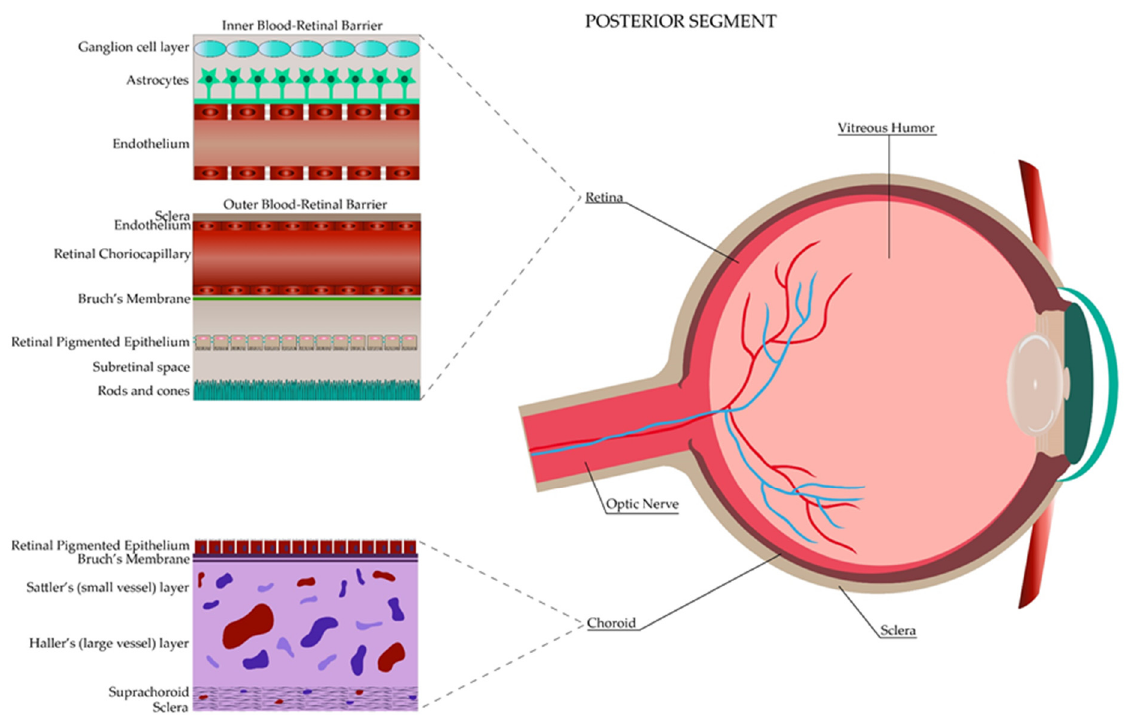
Figure 2. Posterior Segment of the eye.